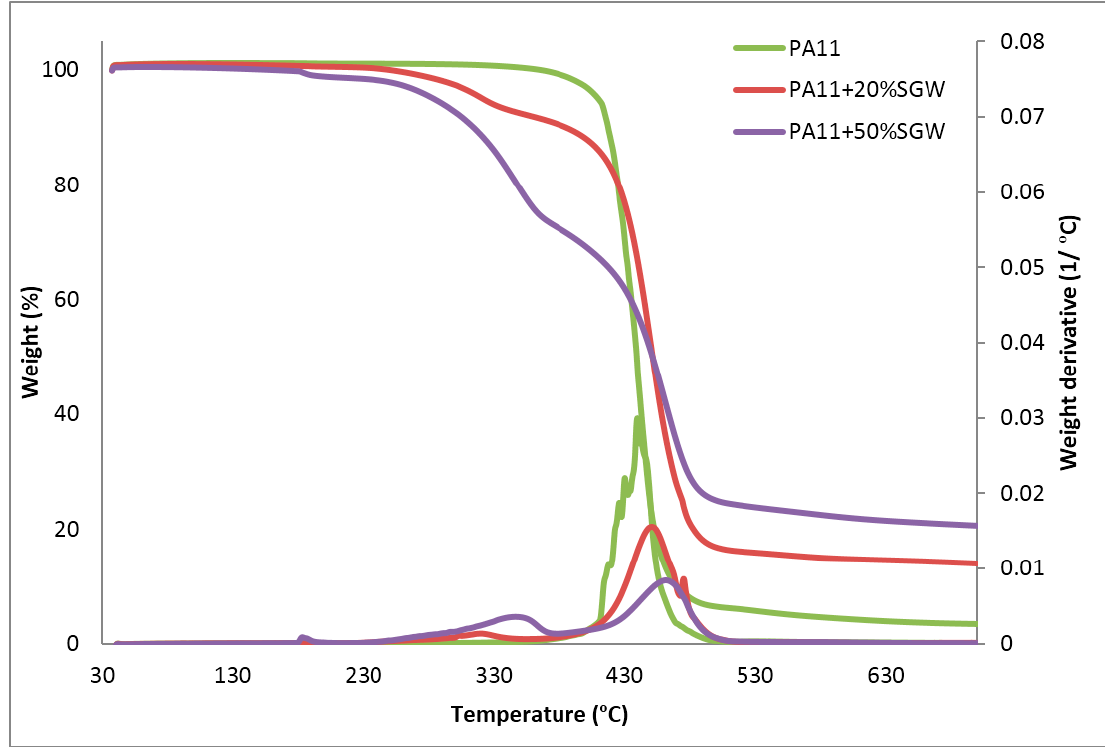
Figure 1. TGA curves and first derivate of the TGA curve for neat PA11 and PA11-SGW composites.